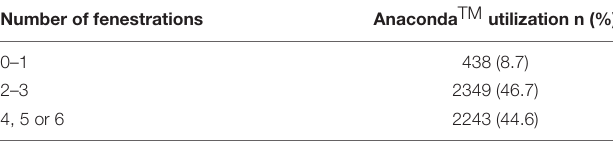
TABLE 5 | Number of devices used according to number of fenestrations used. Number of fenestrations